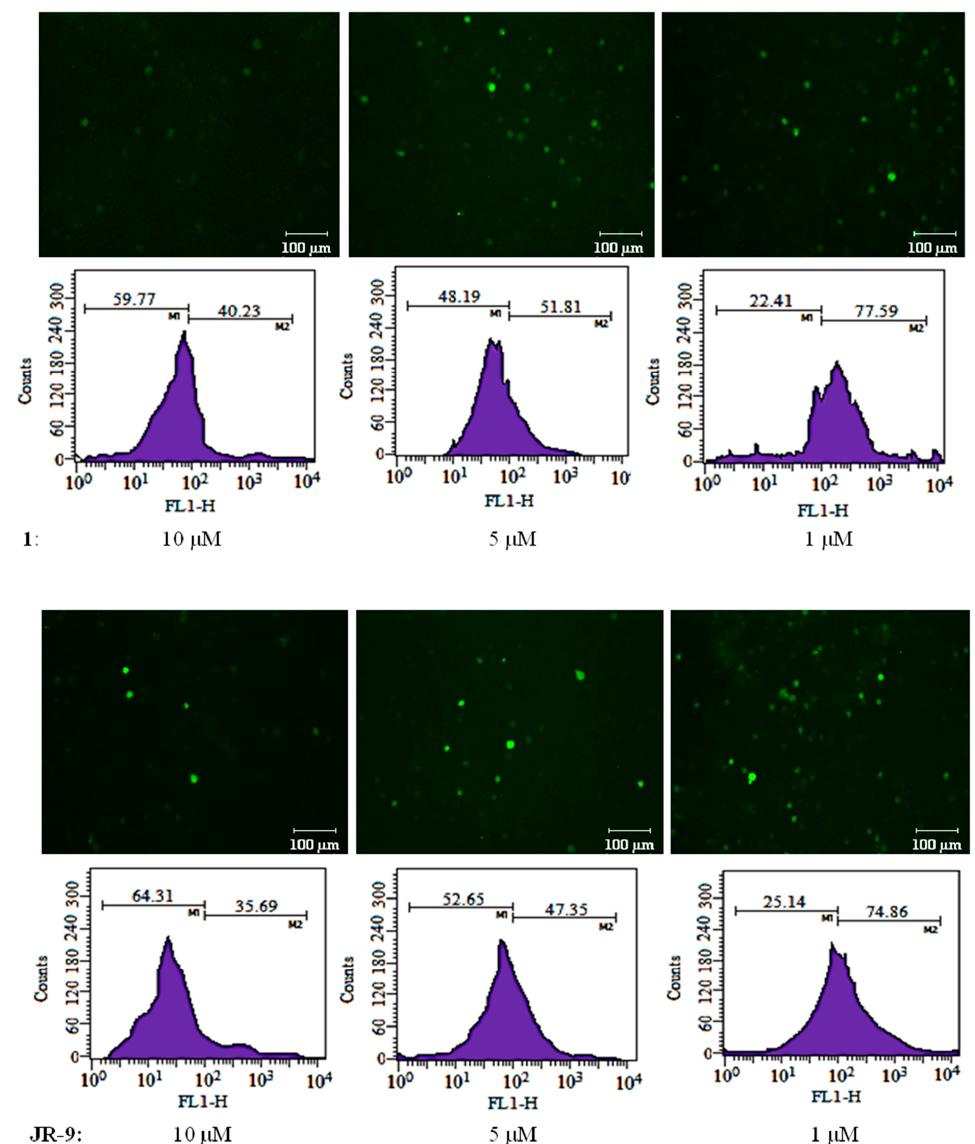
Figure 4. To determine the effect of 1 and JR-9 on the intracellular ROS production, treated RAW 264.7 cells were incubated with DCFH-DA (10 mM) for 30 min. The relative fluorescence intensity of fluorophore DCFH-DA was then measured and detected using BD FACS Aria III flow cytometer (488 nm excitation, 530–540 nm emission), respectively. The results shown are the mean ± standard deviation of three independent experiments.